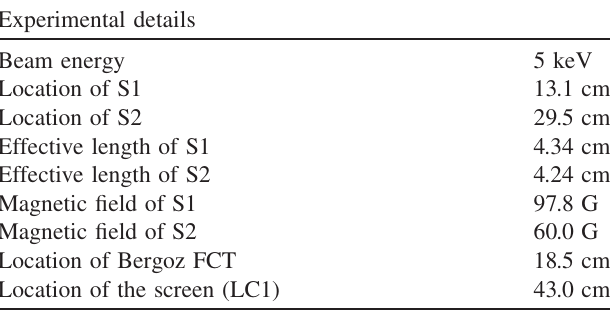
TABLE I. Beam parameters and LSE design